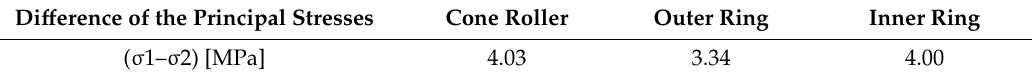
Figure 3. Photoelastic image of the tapered roller bearing model subjected to axial load. Table 3. Principal stresses in tapered roller bearing-photoelasticity.